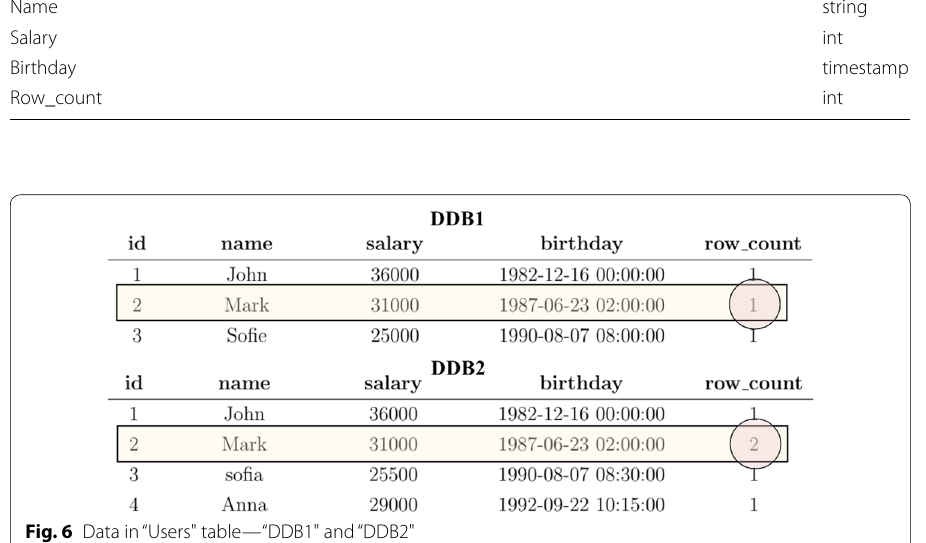
Fig. 6 Data in “Users" table—“DDB1" and